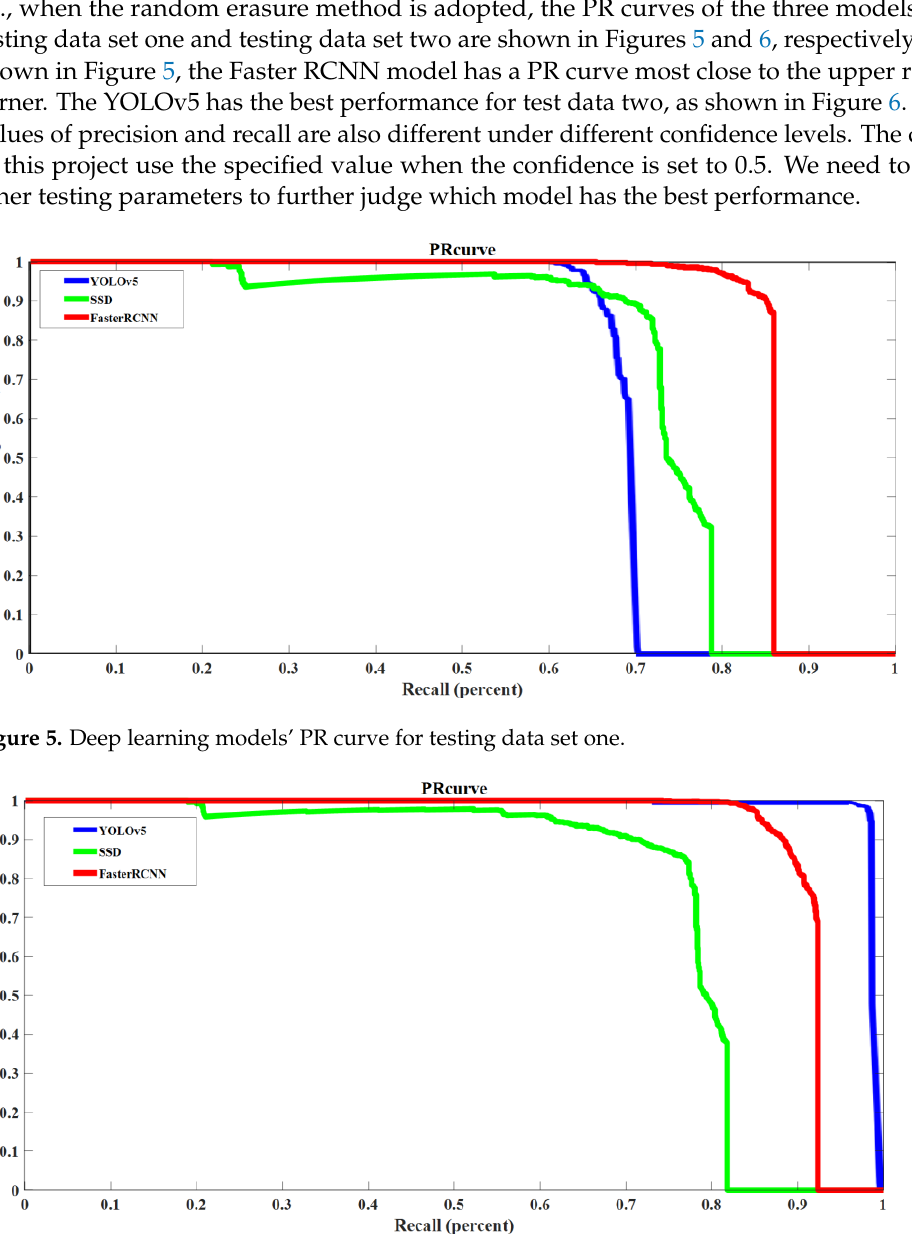
Figure 6. Deep learning models’ PR curve for testing data s et two.